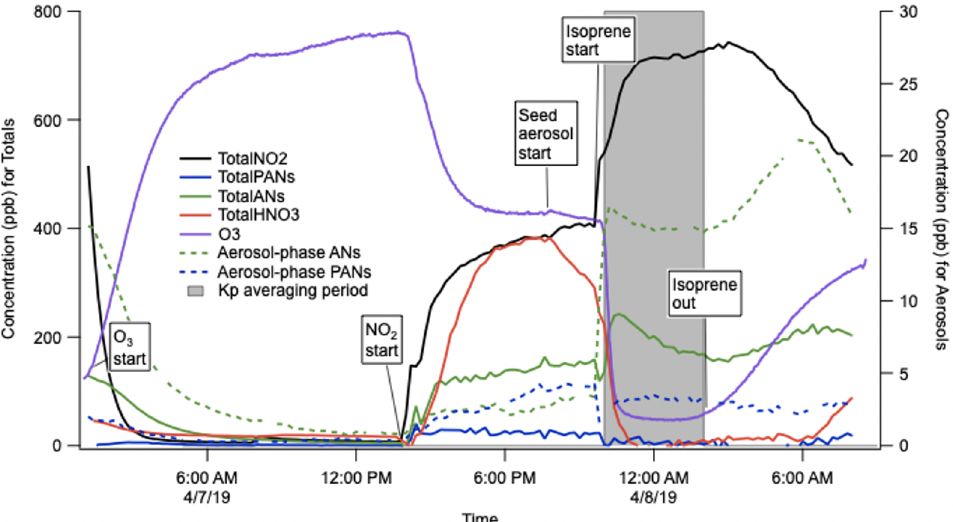
Figure 10. Example experiment to determine the bulk organonitrate partitioning ( K p ) from NO 3 + isoprene products in the Reed Environ- mental Chamber, at 20µgm − 3 ammonium sulfate background aerosol. Note that these traces are not corrected for N 2 O 5 interferences in the AN and PN channel, but N 2 O 5 was fully consumed in the period of K p